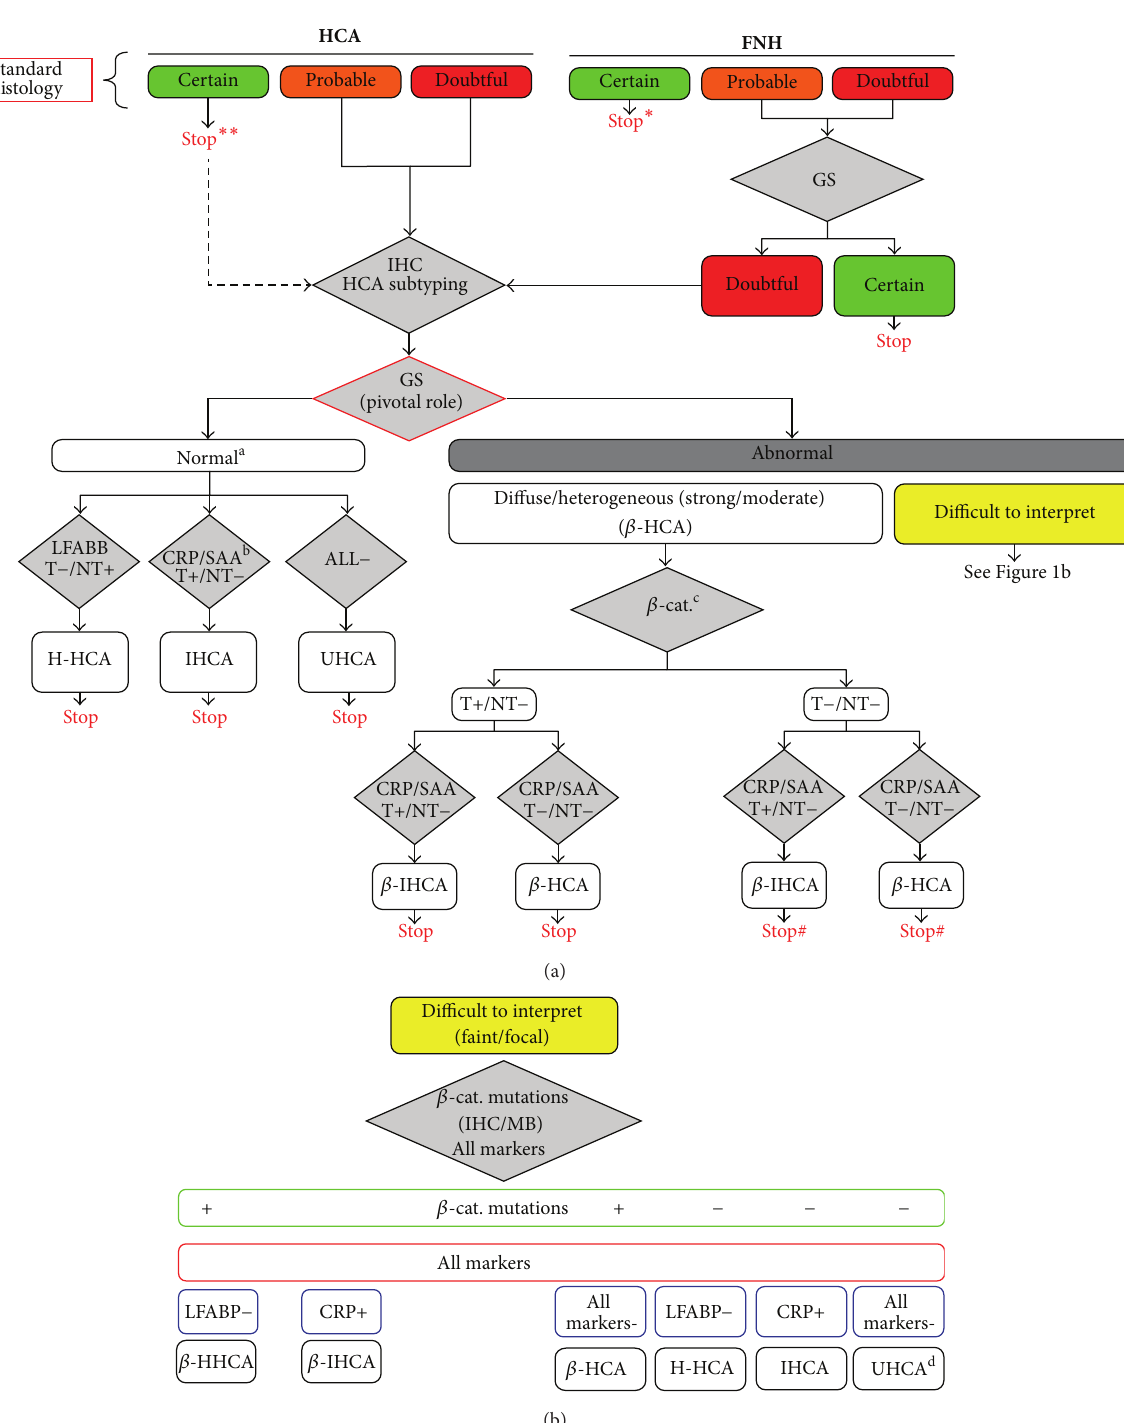
Figure 1: Adapted from Bioulac-Sage et al., [1]. Algorithm for immunohistochemical (IHC) diagnosis of benign hepatocellular nodules: focal nodular hyperplasia (FNH) and hepatocellular adenoma (HCA). Glutamine synthetase (GS) is not always mandatory for the diagnosis of ∗ FNH or ∗∗ HCA in routine practice. IHC is mandatory for HCA subtyping: markers are presented in grey square with their results positive (+) or negative (−) in tumor (T) and nontumoral liver (NT). LFABP: liver fatty acid binding protein; CRP: C-reactive-protein. Final diagnosis of HCA subtypes is: HNF1a inactivated (H-HCA), inflammatory (IHCA), B-catenin activated (B-HCA), B-catenin activated inflammatory (B-IHCA), or unclassified (UHCA). a : GS negativity or positivity limited at the periphery and/or around some veins within HCA. b : serum amyloid A staining is usually less sensitive and specific than CRP. c : aberrant B-catenin nuclear staining. # : needs molecular biology confirmation. d : can be difficult to differentiate from